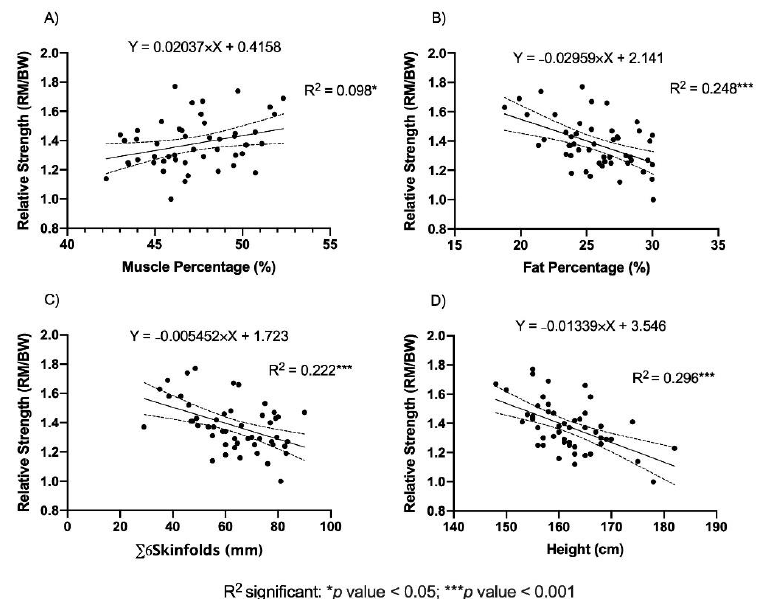
Figure 6. Simple linear regressions between relative strength and anthropometric variables ( A ): Muscle Percent; ( B ): Fat Percentage; ( C ) : Σ6Skinfolds and ( D ): Height.